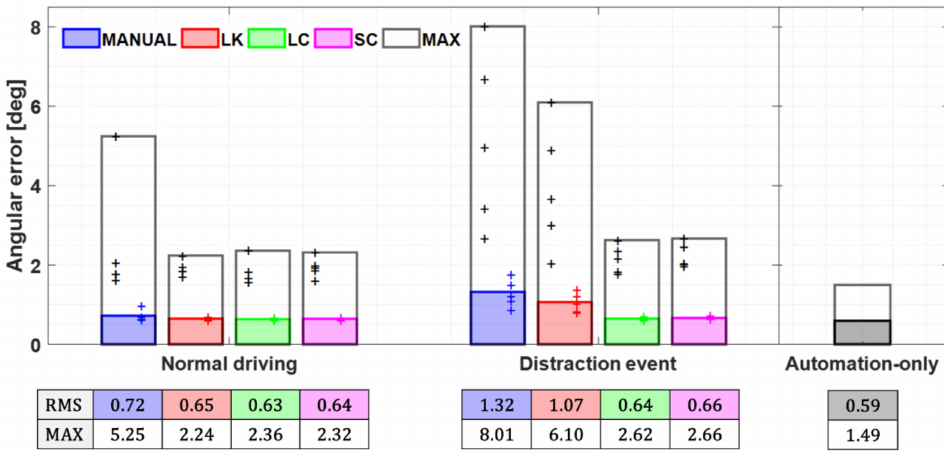
Figure 10. Tracking error statistics (RMS and MAX of lateral error).